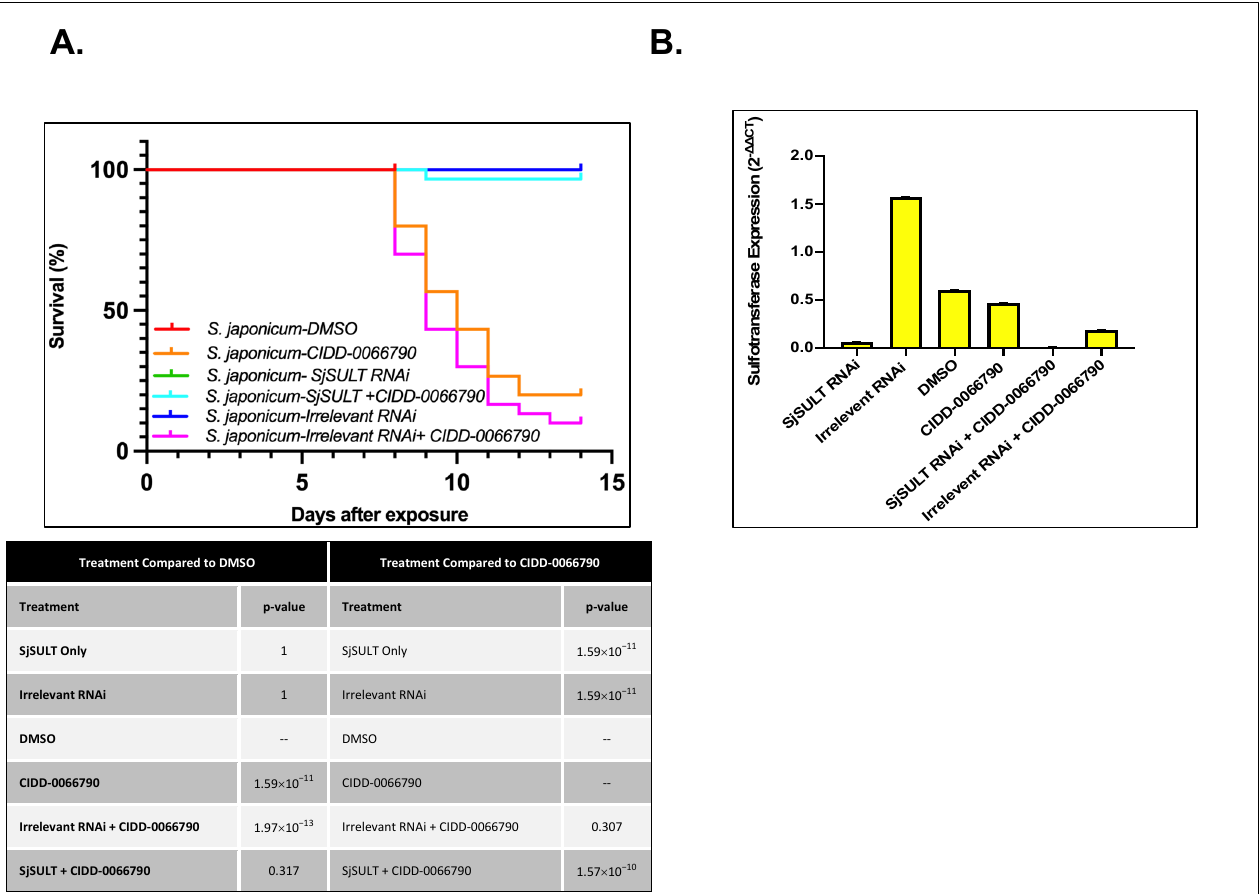
Figure 4. Silencing of SjSULT results in resistant parasites upon challenge with CIDD-0066790. ( A ) Kaplan-Meier survival curve of S. japonicum parasites. Survival curve analysis of adult, male S. japonicum parasites challenged with CIDD-0066790 with or without RNAi treatment. Parasites were cultured for 14 days. RNAi treatment occurred as stated in schematic of Figure 1A. Irrelevant RNAi and SjSULT RNAi alone had 90%+ survival and were displaying healthy characteristics (no signs of shedding, blebbing, and interval vacuolization) and movement confirming that SjSULT is required for CIDD-0066790 activation. ( B ) SjSULT -specific knockdown using RNA interference Quantitative PCR (qPCR) was conducted to confirm gene silencing of S. japonicum sulfotransferase ( SjSULT ). Gene expression in SjSULT RNAi group was significantly reduced by about 95–99% when compared to other treatment groups. GAPDH was used as the endogenous control. There was a no-treatment group that was just male worms (not shown), which was used as the control, which was the sample that was set to